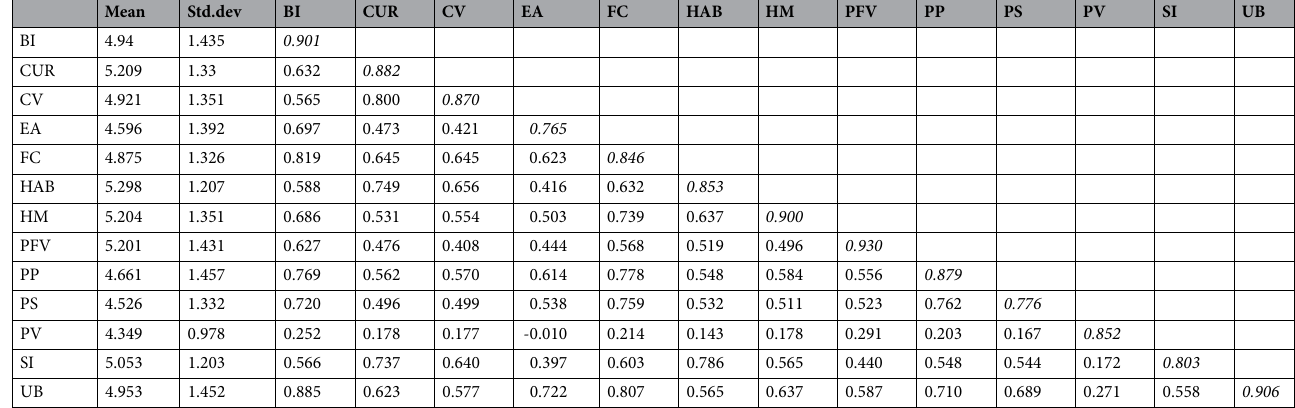
Table 2. Discriminant Validity. PP = Perceived Performance; PFV = Perceived Functional Value; PV = Perceived Value; PS = Perceived Satisfaction; HAB = Habit. Hedonic Motivation; CUR = Curiosity; SI = Social Influence; EA = Environmental Awareness; FC = Facilitating Condition; CV = Cost Value; BI = Behavioral Intention; UB = Usage Behavior. Significant values are in